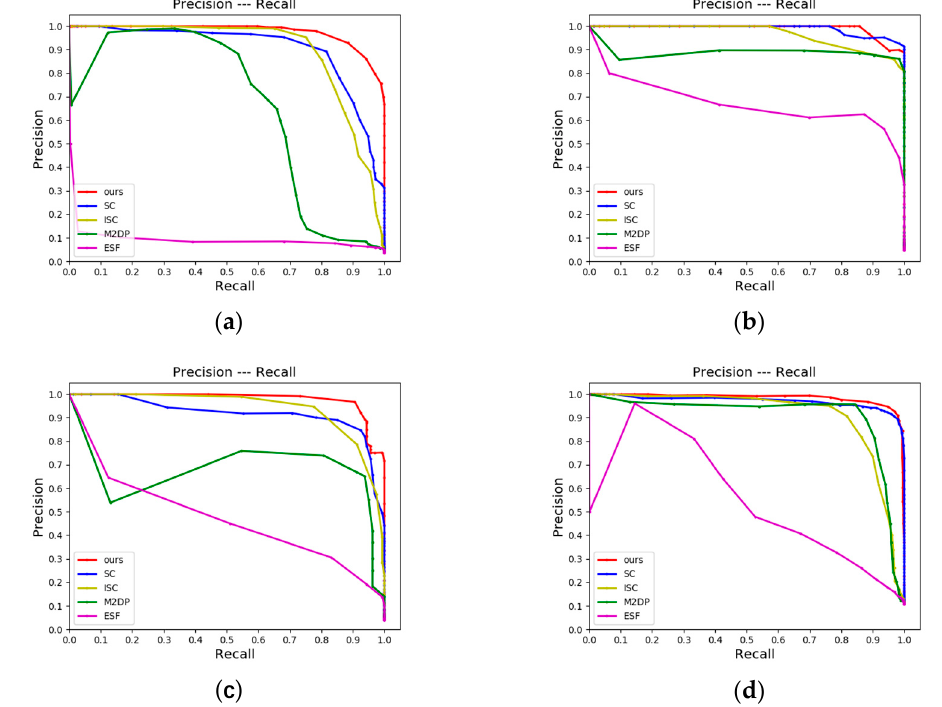
Figure 7. P-R curves corresponding to JLU datasets should be listed as the ( a ) P-R curve of jlu00; ( b ) P-R curve of jlu01; ( c ) P-R curve of jlu02; ( d ) P-R curve of jlu03.